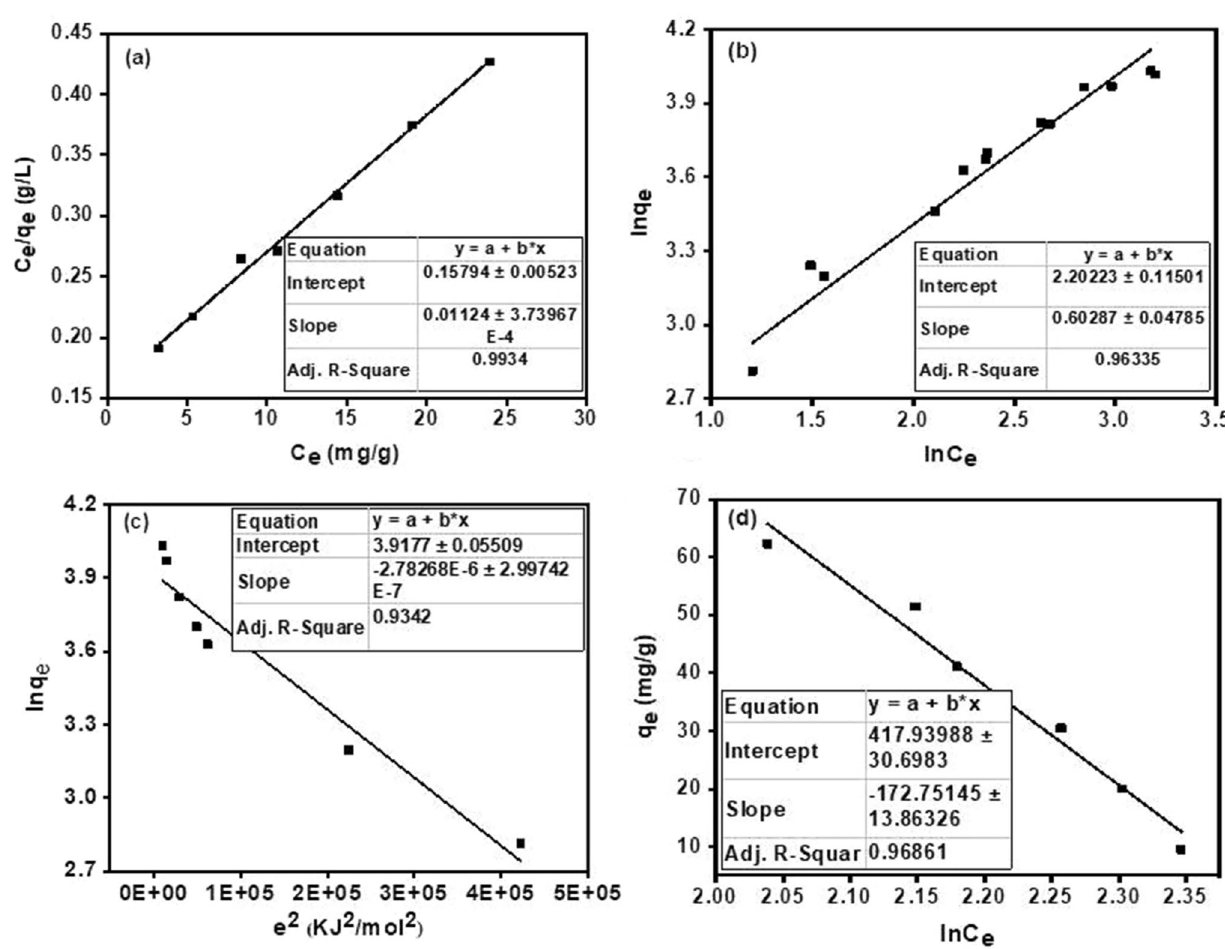
Fig. 12 a Plot of Langmuir adsorption isotherm, b Pot of Freundlich adsorption isotherm, c Plot of D-R model, d Temkin isotherm